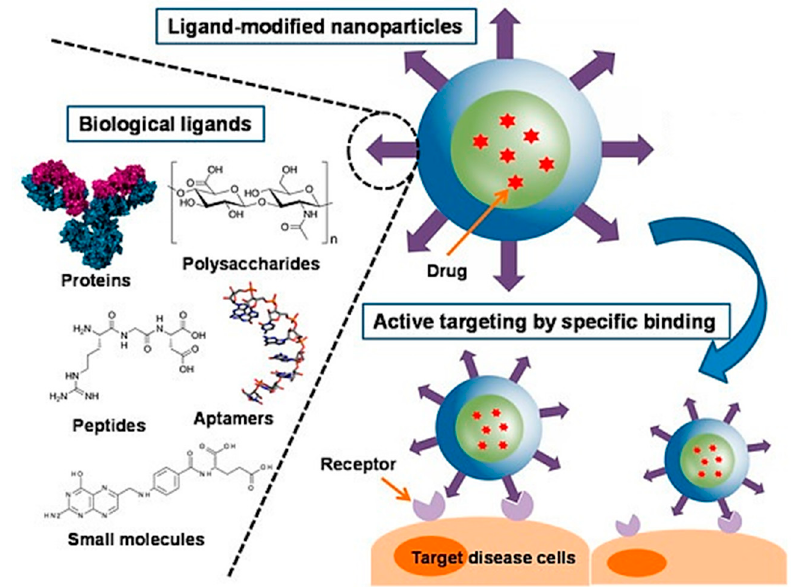
Figure 5. Schematic representation of a surface modified nanoparticle, highlighting examples of ligands used in surface modification and attachment to receptor site. Adapted and modified with permission from [89].